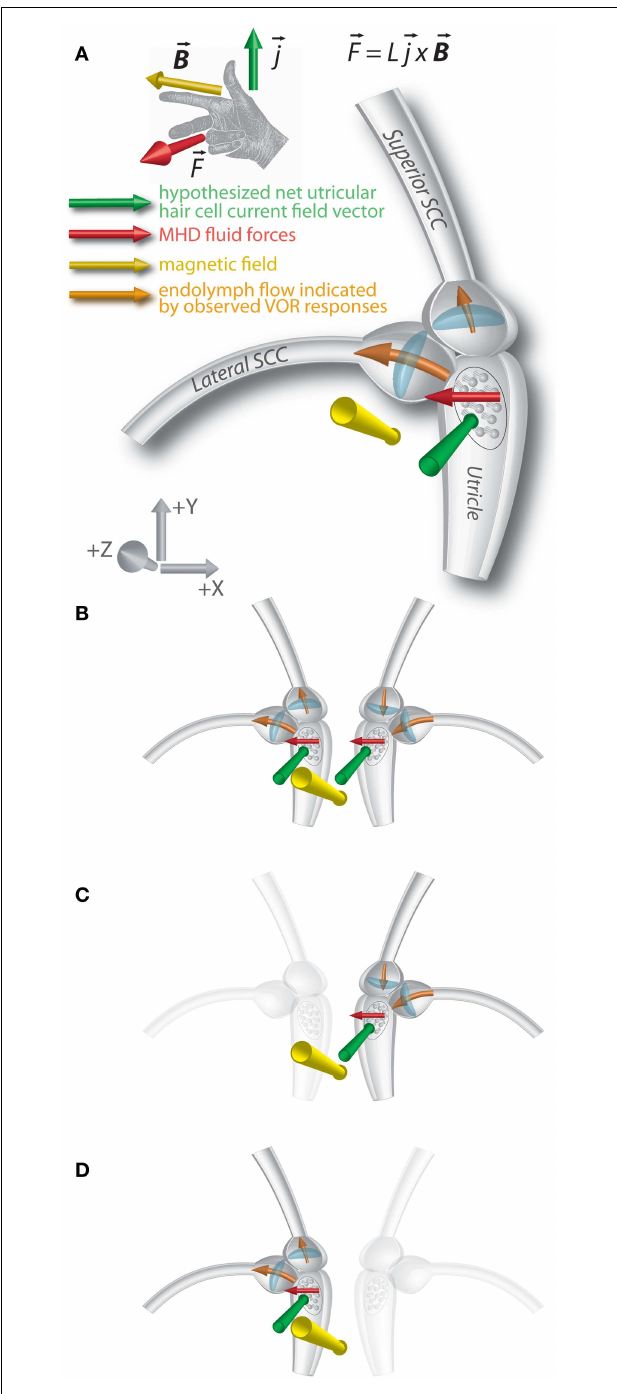
FIGURE 3 | Lorentz force vector diagram of magnetic vestibular stimulation (MVS) . (A) An ionic current in a magnetic field results in a magneto-hydrodynamic (MHD) force ( (cid:69) F ) , represented by the cross product of the current ( (cid:69) j ) and magnetic field vectors ( (cid:69) B ) . L represents the scalar length over which the current flows. A right-hand rule demonstrates this relationship.The MHD force induces endolymph flow, which deflects the horizontal and superior canal cupulae. Axis represents RAS